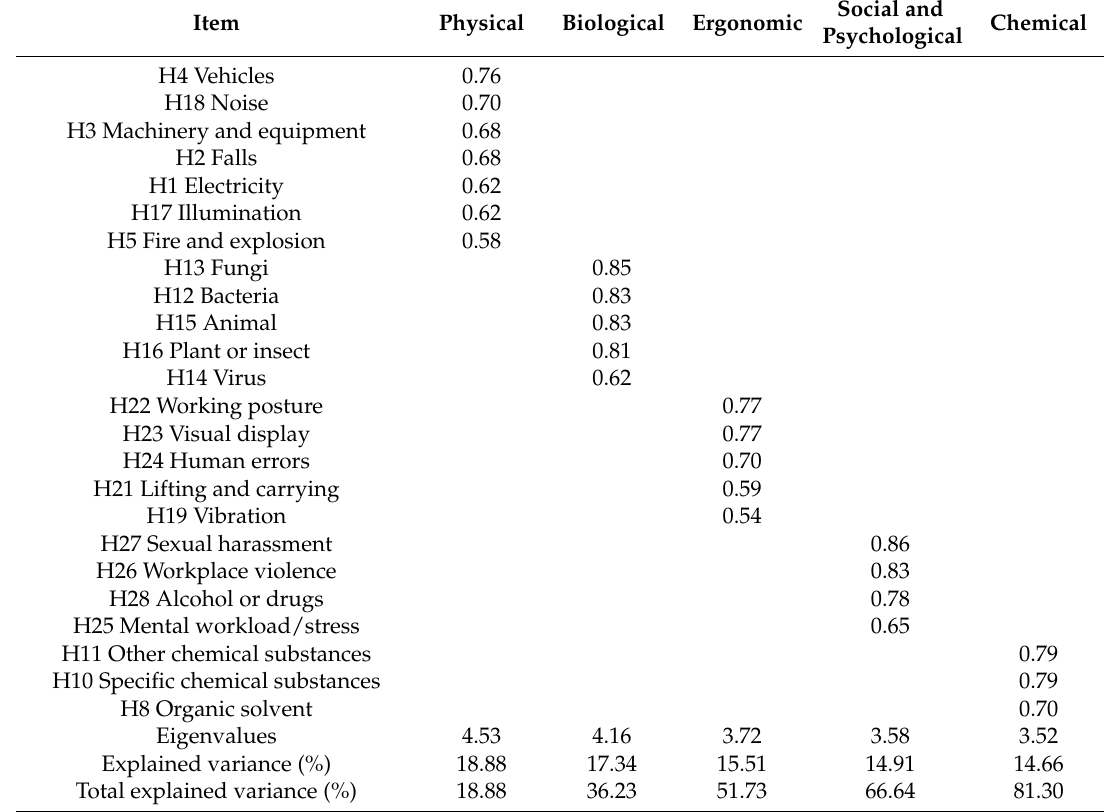
Table 1. The third exploratory factor analysis (EFA) results for hazard management